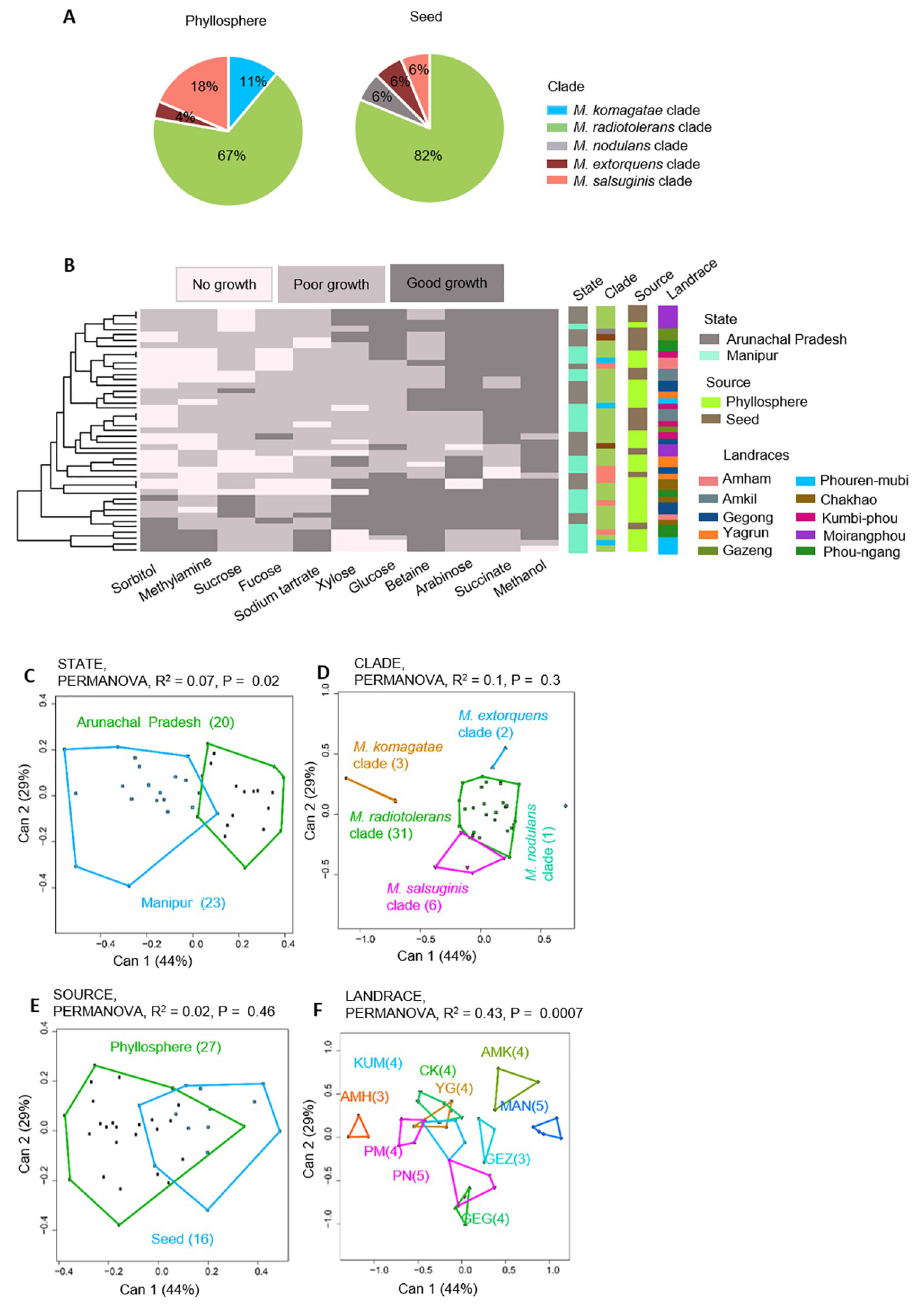
Fig 6. Phenotypic variation in the Methylobacterium isolates from phyllosphere and seed. (A) Piecharts showing Methylobacterium clade composition from phyllosphere vs. seed surface. (B) A summary of the ability of 43 Methylobacterium isolates (from sources described in panel A) to utilize a panel of 11 carbon sources. Each row represents one isolate; each column represents a carbon source; and cells are colored based on qualitative growth of each isolate in each carbon source. Isolates are clustered (see dendrogram on the left) based on Euclidian distances and Ward clustering, given their carbon use phenotype. Columns to the right represent potential explanatory variables for the carbon use profile of each isolate, and are colored by state, source, Methylobacterium clade, and landrace. (C-F) Canonical variance analysis biplots of carbon use profiles, showing the clustering of all 43 Methylobacterium isolates by (C) state, (D) Methylobacterium clade, (E) source, and (F) landrace. Each point represents an isolate, and numbers in parentheses indicate the number of isolates in each group. Convex hulls represent 95% confidence intervals.